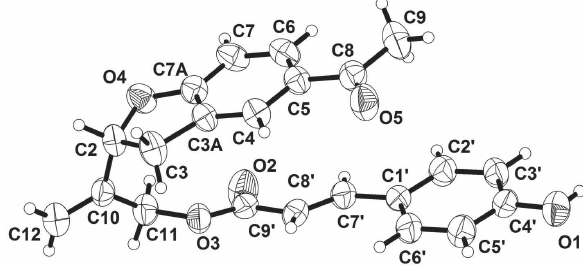
Table 1: Data collection and